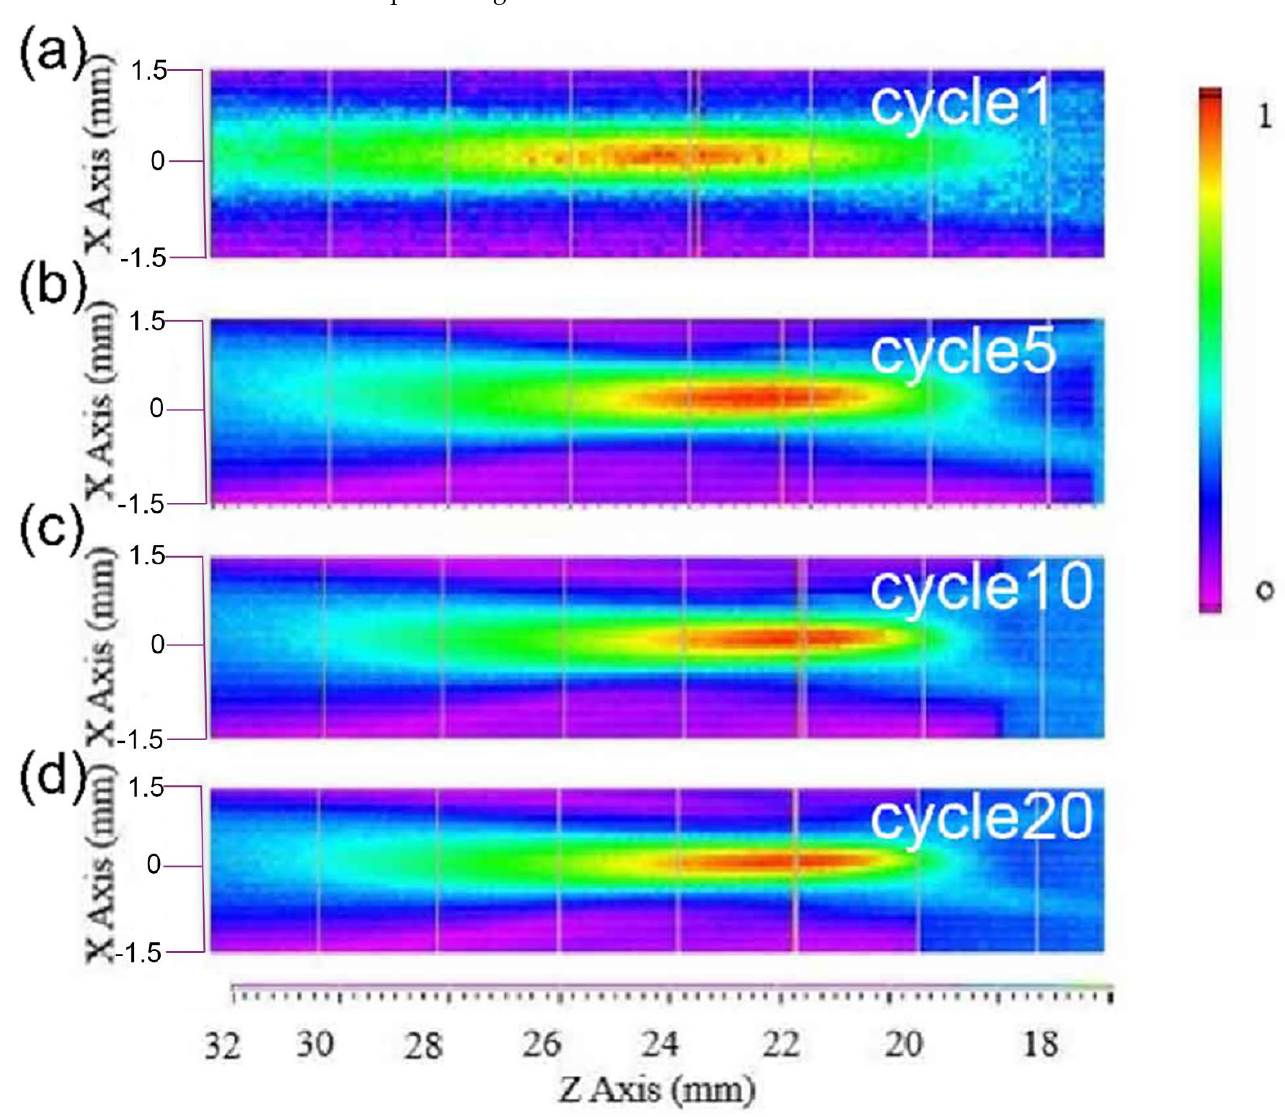
Figure 9. ( a – d ) Normalized intensity maps of the pressure fields from the Fresnel lens-focused transducer with different cycle numbers of excited signal.